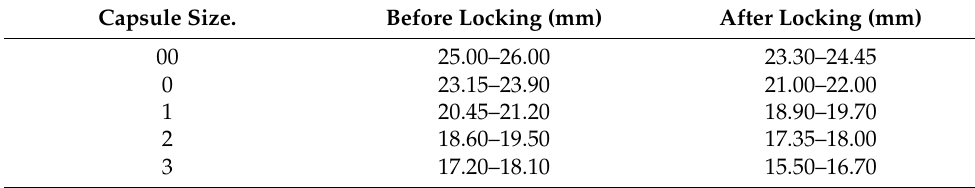
Table 3. Length specification of hard gelatine capsules.